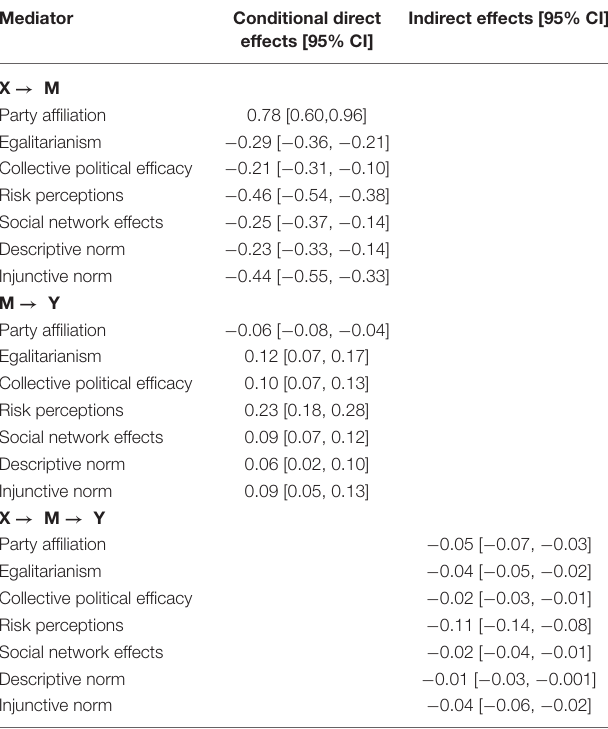
TABLE 5 | Significant mediators of intentions to contact government